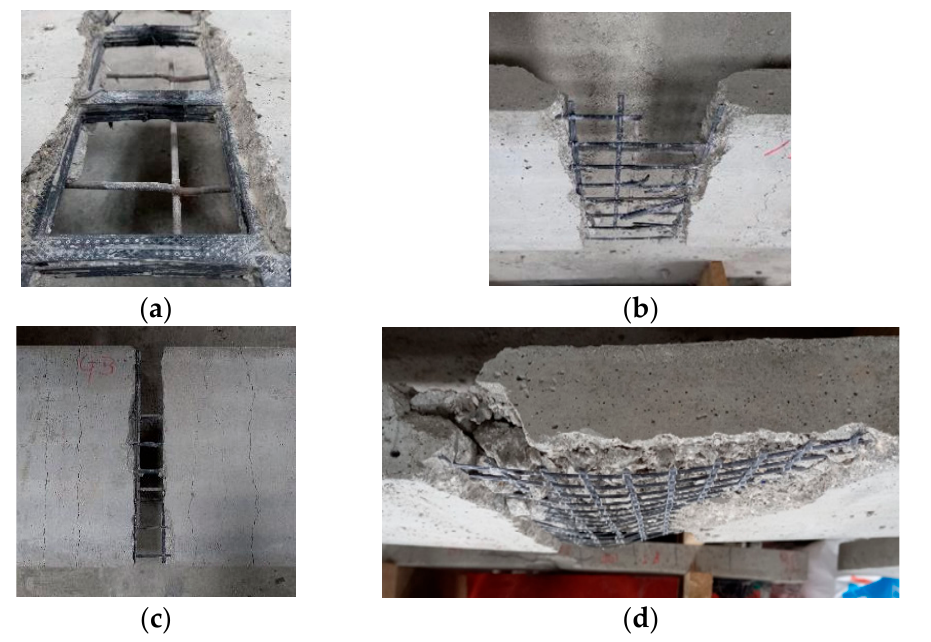
Figure 7. Specimen crack spaces.